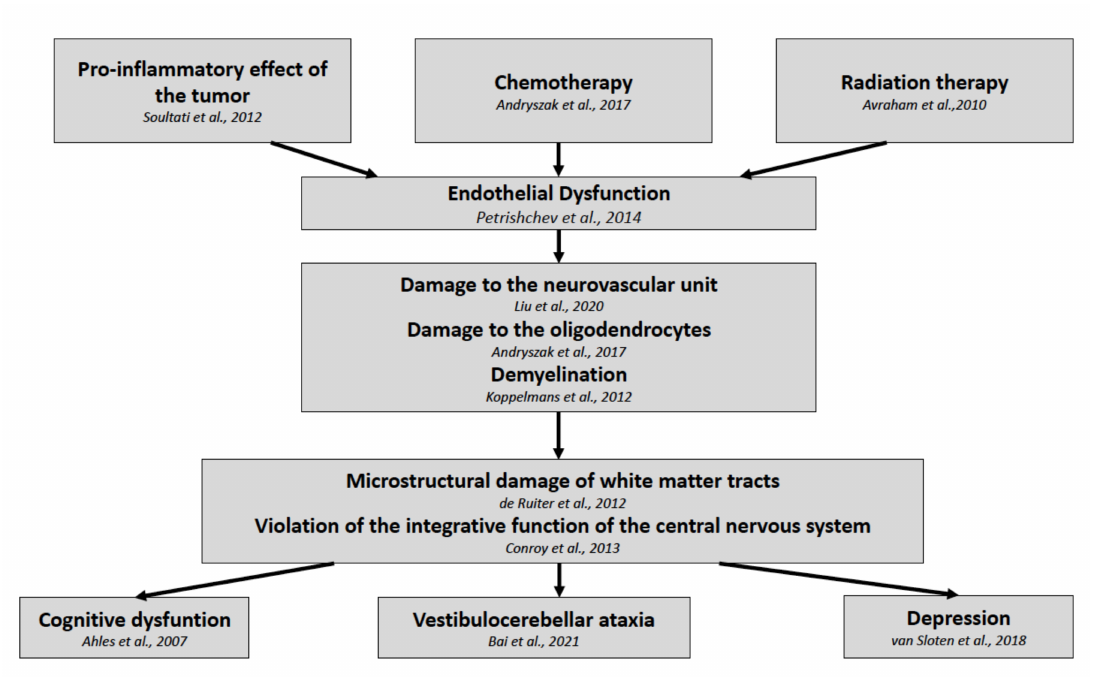
Figure 2. Pathophysiological development of post-treatment symptoms in breast cancer